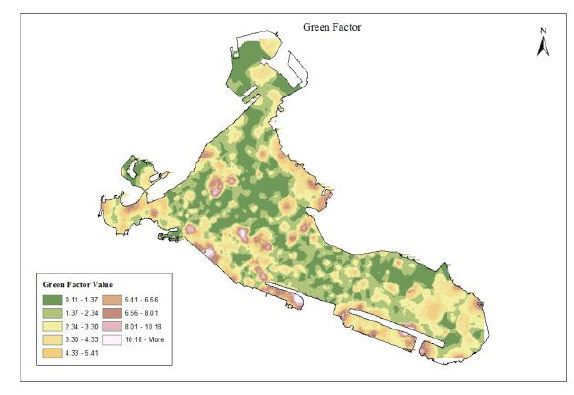
Figure 7 Reduced CO2 (energy reduction and Green factors)